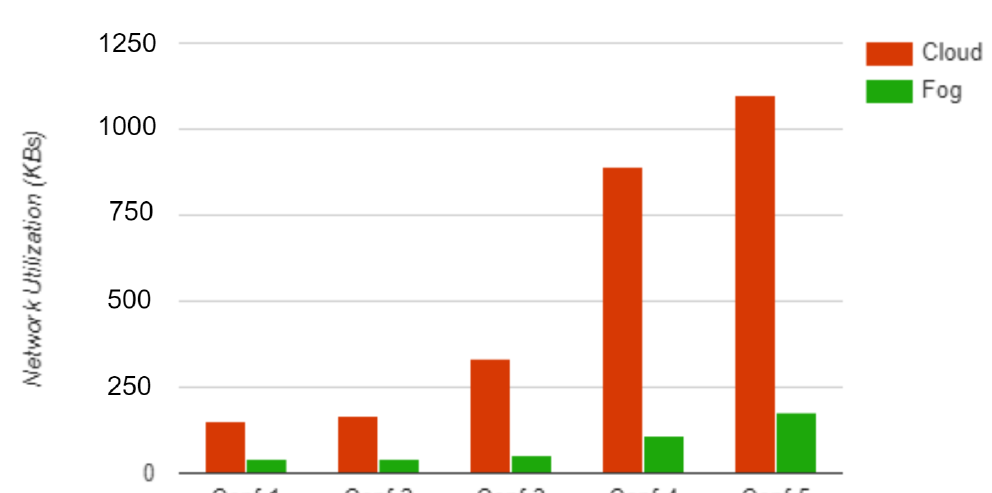
Figure 9. Latency.